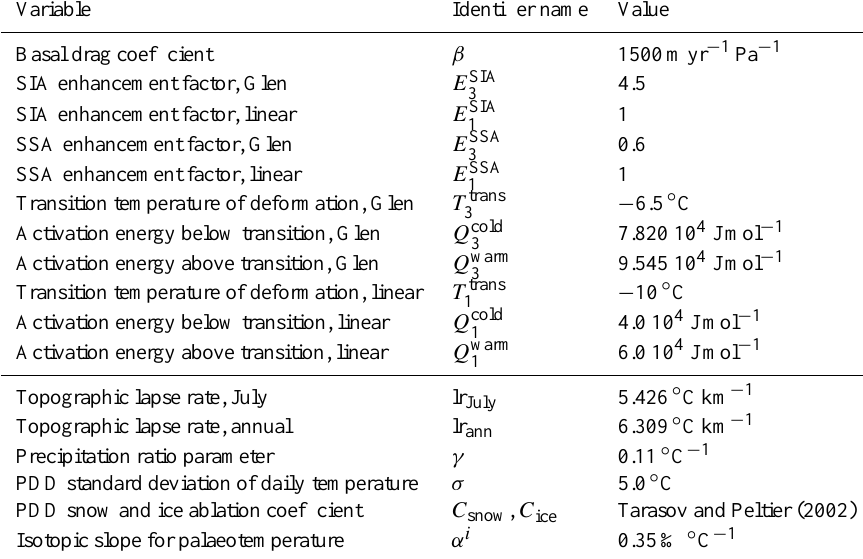
Table 2. Model parameters used in GRISLI for this